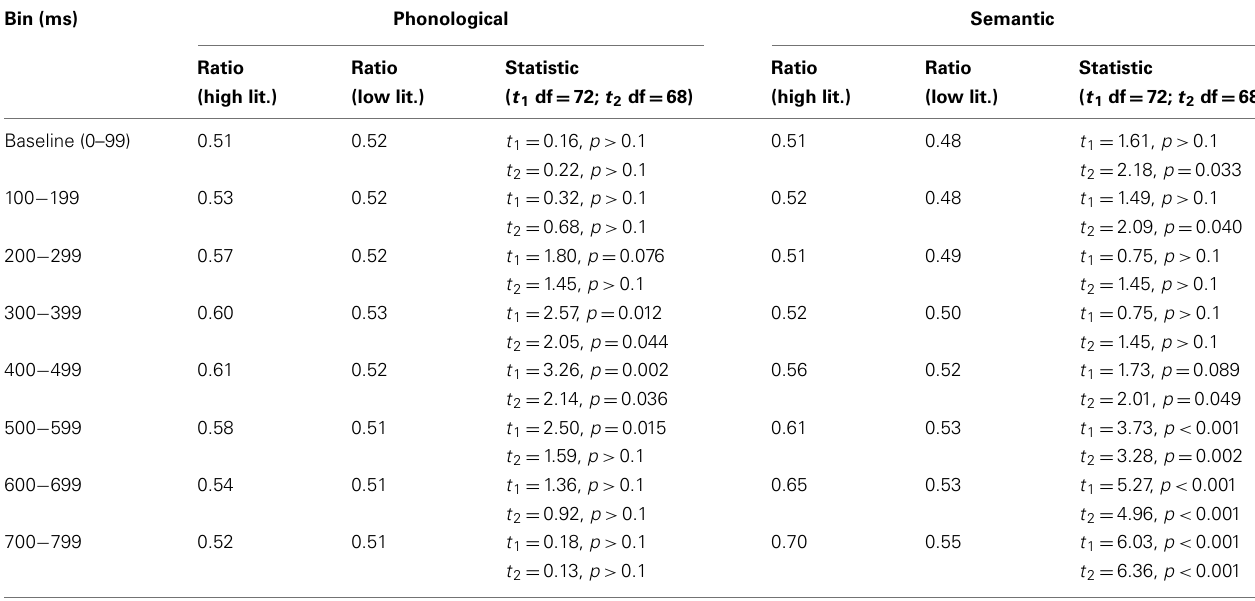
Table 1 | Group comparisons (Experiment